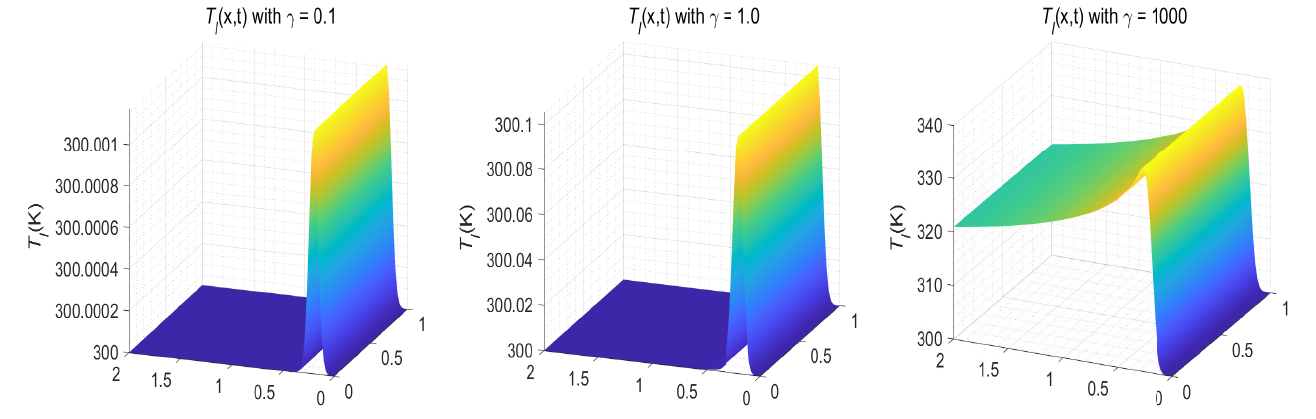
Figure 21. Temperature distributions of T l versus ( x , t ) with various γ when K n = 618.4658, ( α , β ) = ( 0.3,0.8 ) , N = 100, and M = 100 for Example 2.